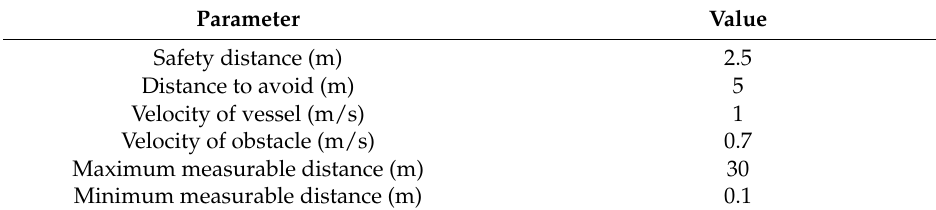
Table 8. Parameters of the advanced SBG.